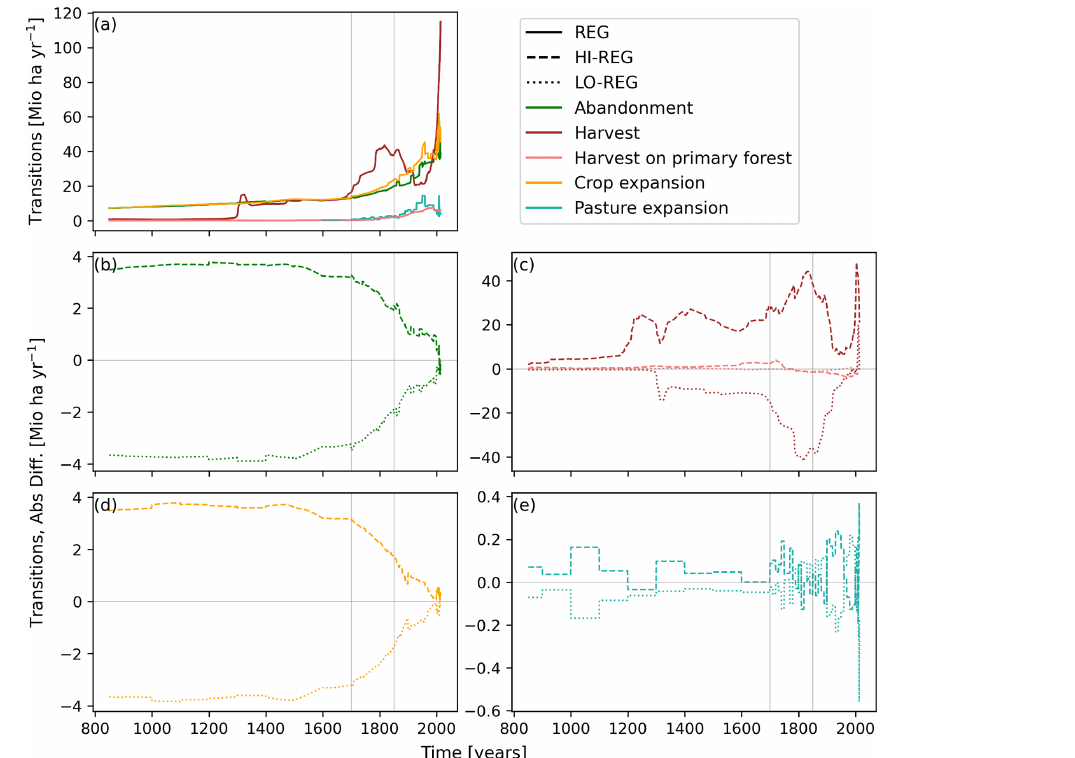
Figure A2. Global gross transitions based on LUH2 baseline scenario (REG) (a) and absolute difference of high (HI) and low (LO) land-use estimates compared to the baseline LUH2 setup (b–e) . For harvest (c) , the subtransition of harvest on primary forest is shown as well. Note the different y -axis ranges.